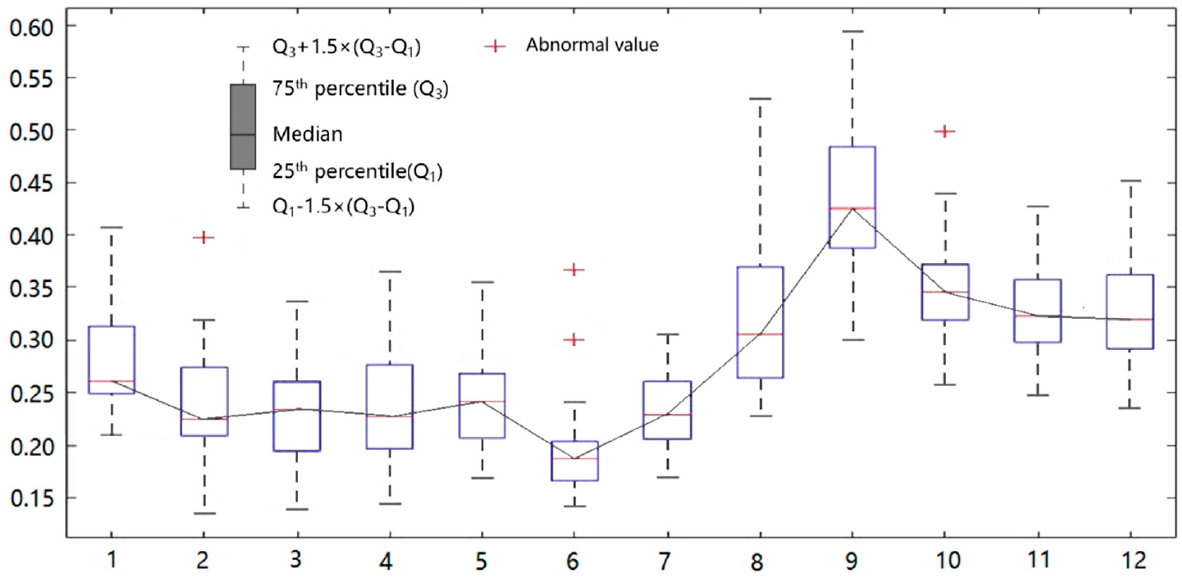
Figure 3. Monthly precipitation recycling ratio in the middle and lower Yangtze River region (1981–2015).